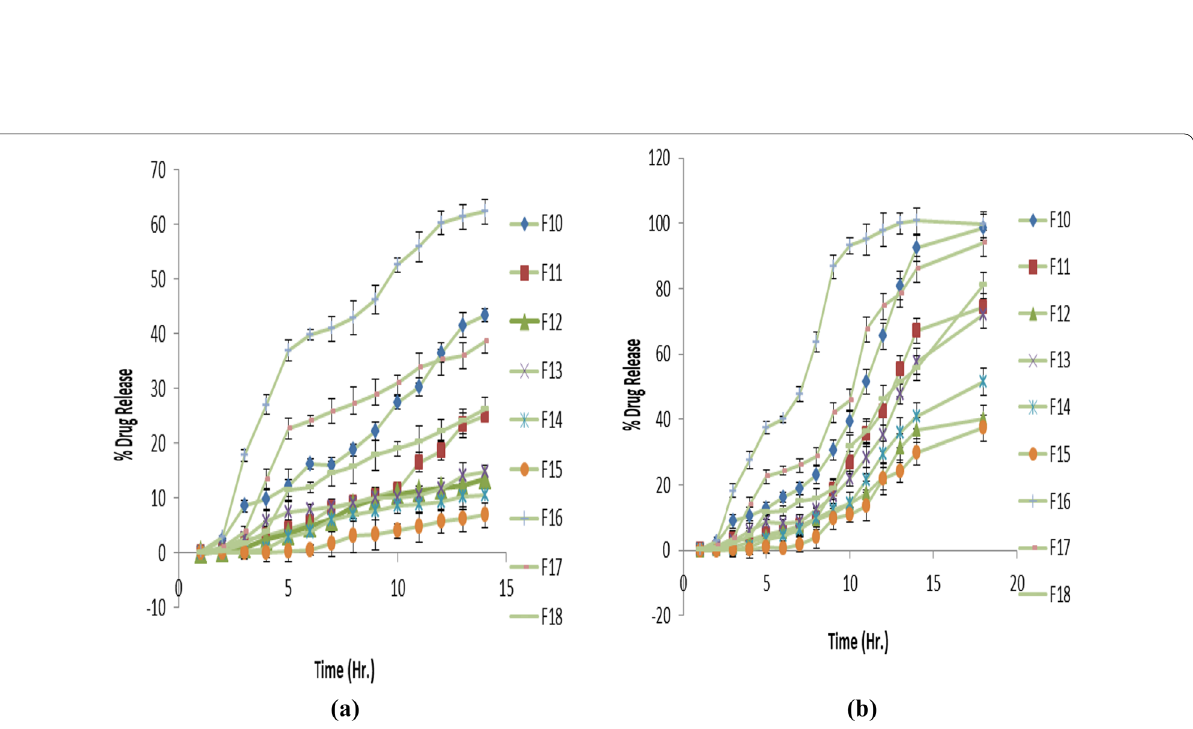
Fig. 3 In vitro drug release profiles of satranidazole pellets (Batch F10‑F18) at a simulated gastrointestinal fluid (pH 1.2, pH 4.5 and pH 7.4) and b simulated colonic fluid (pH